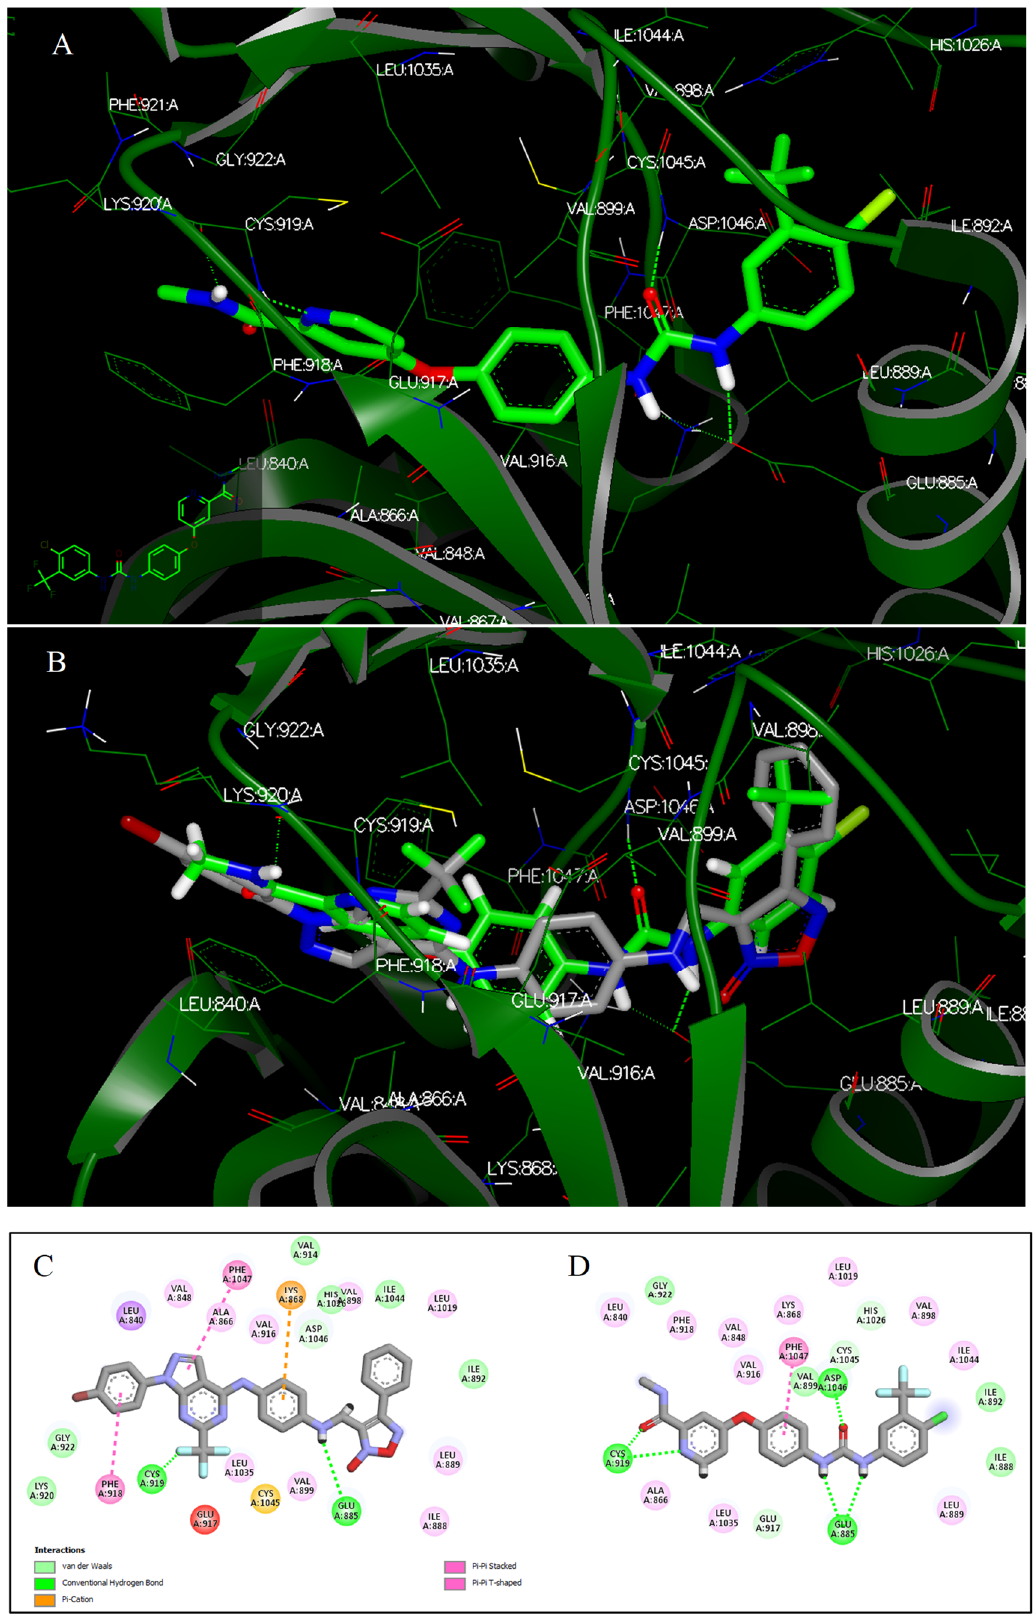
Figure 13. Binding interactions in the active site of VEGFR-2: ( A ) 3D representation of sorafenib; ( B ) 3D representation of 12b (grey) showing an overlay with sorafenib (green); ( C ) 2D diagram of 12b ; ( D ) 2D diagram of sorafenib.